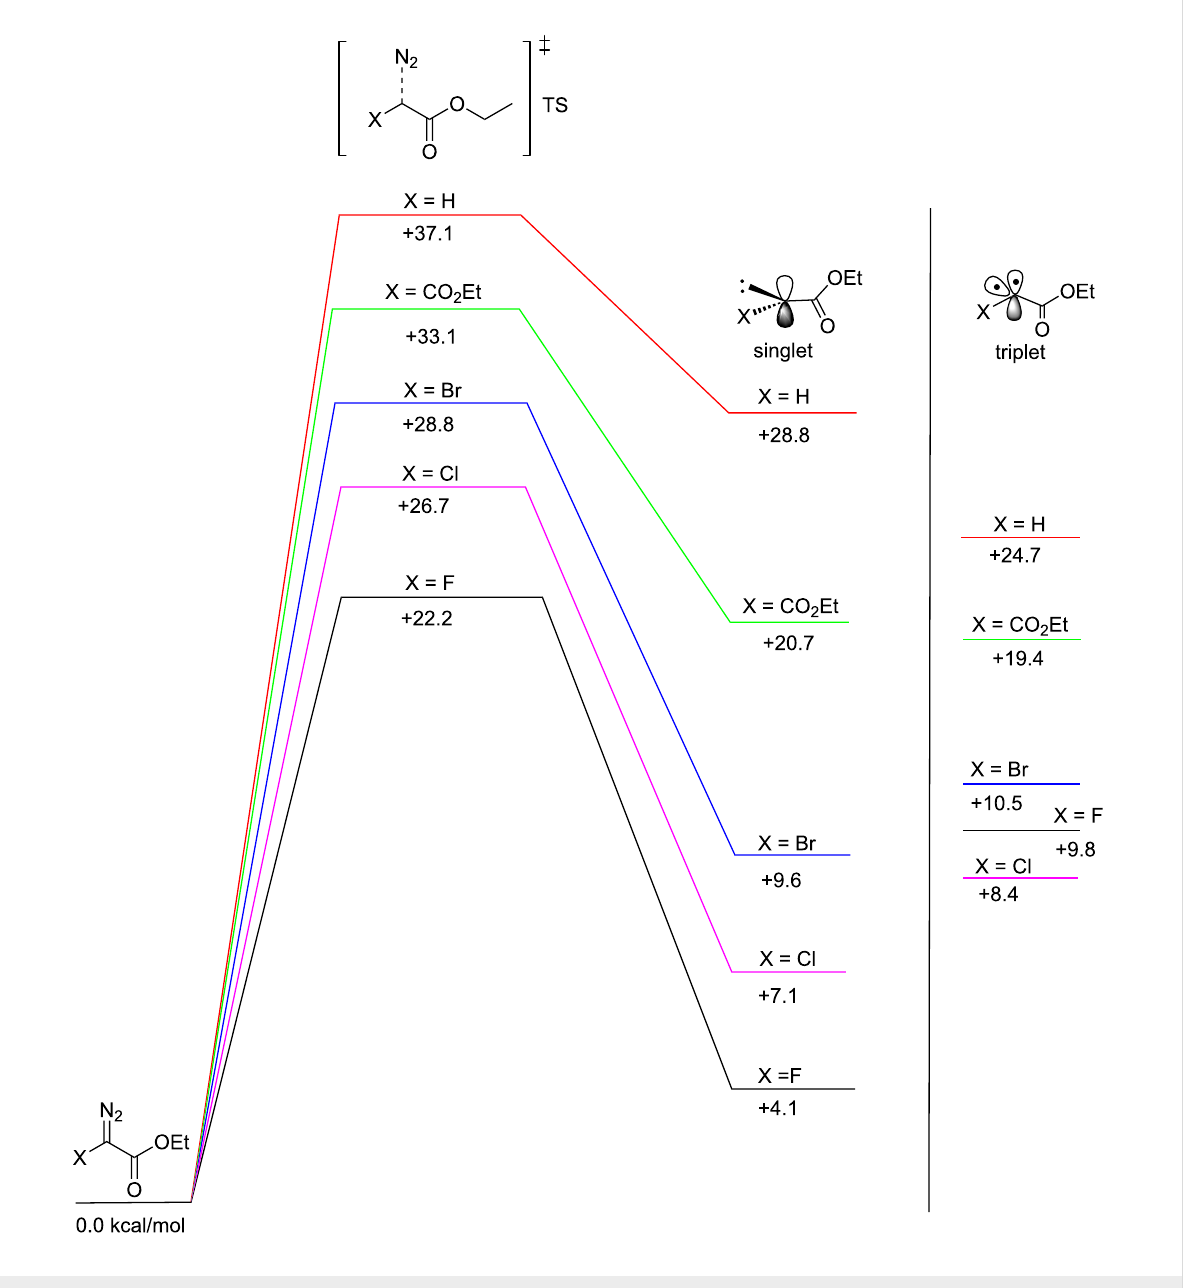
Figure 3: Transition-state energies (kcal/mol) for the release of N 2 and formation of the singlet carbenes. The corresponding triplet carbenes are displayed to the right.